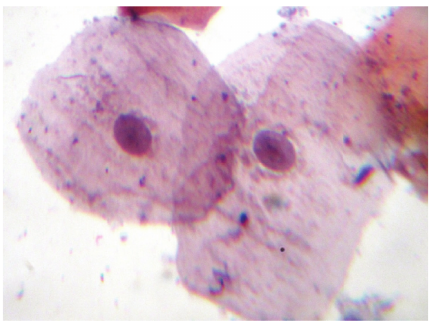
Figure 2: Photomicrograph showing epithelial cells with nuclear pleomorphism, prominent nucleoli, hyperchromatism, and micro- nuclei